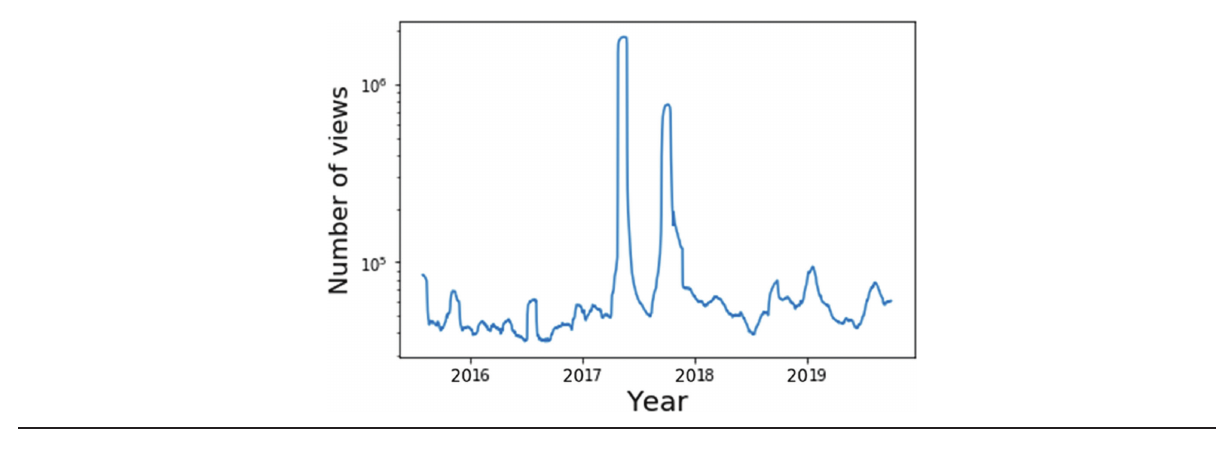
Figure 9. Daily viewing figures for Wikipedia articles on Cassini–Huygens in 72 languages; the curve has been smoothed with a 30-day rolling average (Source: Authors, 2022)